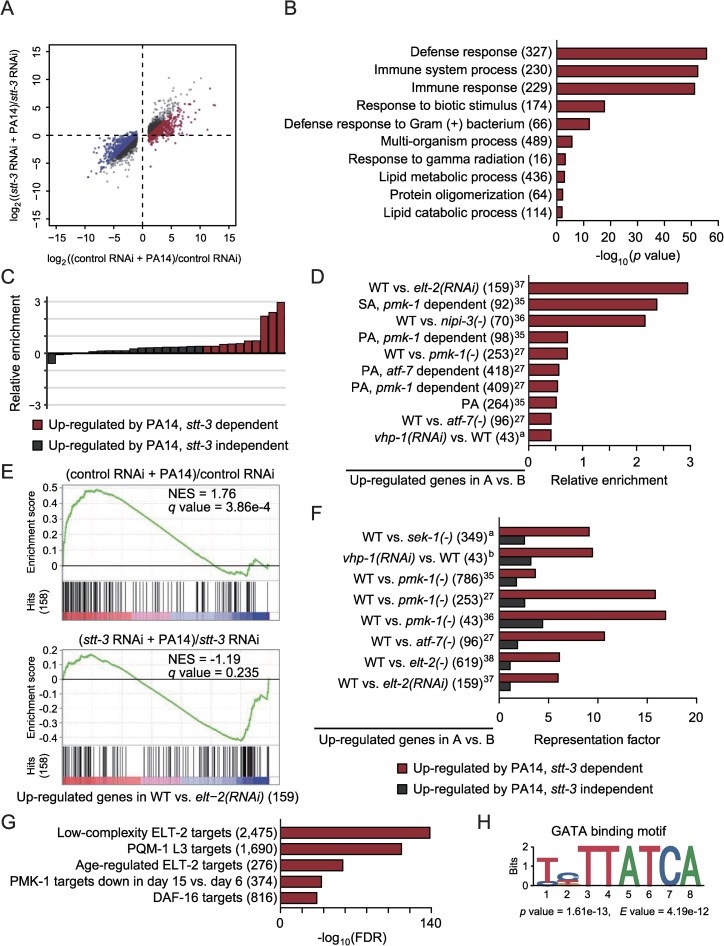
OST complex mediates PMK-1-dependent induction of a subset of PA14-responsive genes.(A) A scatter plot showing the effects of RNAi targeting stt-3 on the expression levels of mRNAs that were significantly changed by PA14 infection (fold change > 2, BH-adjusted p value < 0.05). Red dots and blue dots indicate stt-3-dependent 569 up- and 569 down-regulated genes, respectively (fold change > 2 and BH-adjusted p value < 0.05 by PA14 in control RNAi, but the changes were reduced by fold > 2 by stt-3 RNAi). (B) Overrepresented GO terms of genes induced by PA14 in an stt-3-dependent manner. The numbers of genes for individual terms are indicated in parentheses. (C) Twenty-nine gene sets whose expression was significantly increased by PA14 (q value < 0.25). The relative enrichment (NES(ctrl RNAi + PA14)/ctrl RNAi−NES(stt-3 RNAi + PA14)/stt-3 RNAi) indicates the extent of expression changes of a gene set by PA14 with or without stt-3 RNAi. Red bars represent 10 stt-3-dependent PA14-induced sets. Grey bars represent stt-3-independent PA14-induced sets, some of which are shown in S4 Fig. (D) stt-3-dependent PA14-enhanced gene sets. In addition to PMK-1 signaling component genes, we noticed that genes whose activation was dependent on NIPI-3, another regulator of immunity against PA14 [42], were associated with genes up-regulated by PA14 in an stt-3-dependent manner. PA: PA14. SA: Staphylococcus aureus. Superscript numbers indicate references that include corresponding transcriptomic data. a data (GSE82238) in GEO. The numbers of genes for individual categories are indicated in parentheses. (E) Genes up-regulated in an ELT-2-dependent manner [43] were induced by PA14 in an stt-3-dependent manner. NES: normalized enriched score. q values were obtained by calculating the false discovery rate (FDR) corresponding to each NES. (F) Representation factors for overlaps between stt-3-dependent or stt-3-independent PA14-induced genes and PMK-1 signaling component-encoding genes. a data (GSE92902) and b data (GSE82238) in GEO. The numbers of genes for individual categories are indicated in parentheses. (G) Targets of transcription factors specifically associated with stt-3-dependent PA14-induced genes. The numbers of genes for individual categories are indicated in parentheses. (H) A GATA binding motif (MA0542.1) in JASPAR CORE [81] enriched in promoter regions (-1 kb to +100 bp) of stt-3-dependent PA14-induced genes compared to corresponding positions of stt-3-independent PA14-induced genes.